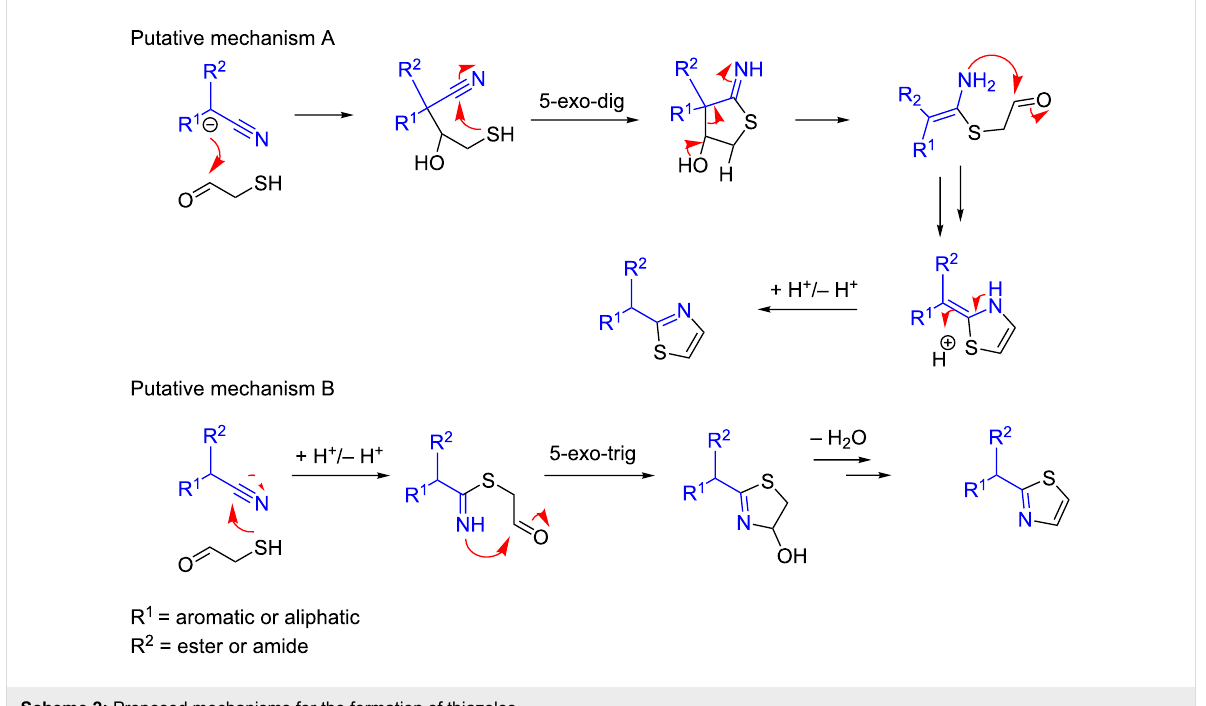
Scheme 2: Proposed mechanisms for the formation of